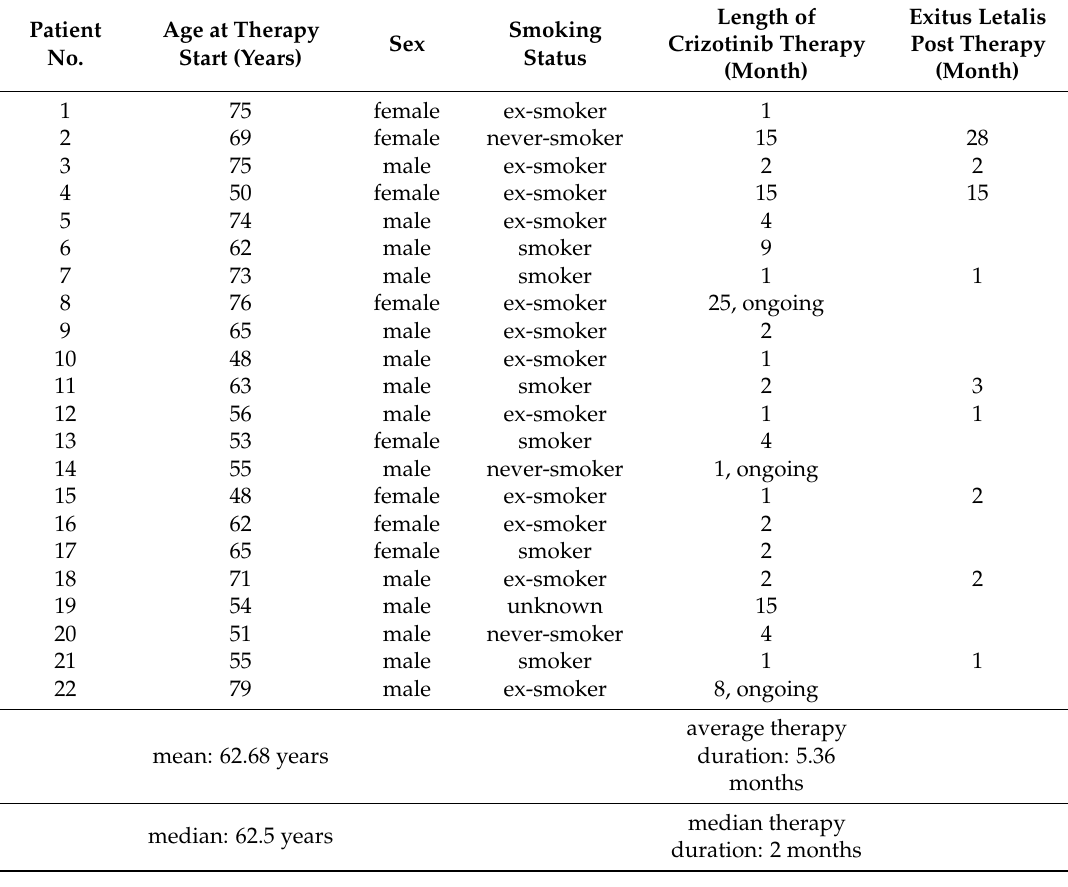
Table 1. Overview on the patient cohort that was used as the basis for the subsequent health-economic analyses (target date for ongoing therapy 30 June